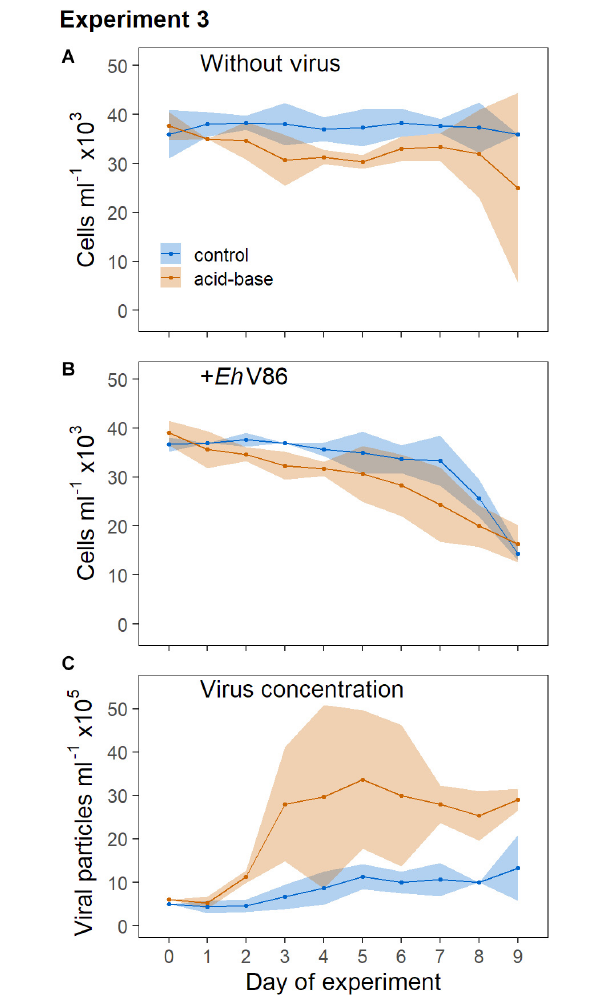
FIGURE 6 | Addition of virus to calcified cells and cells under low [Ca 2 + ] in permanent darkness. Sample mean ± 95% CI ( n = 3). (A) Concentration of calcifying E. huxleyi CCMP1516 without virus and (B) when virus was added; (C) concentration of viral